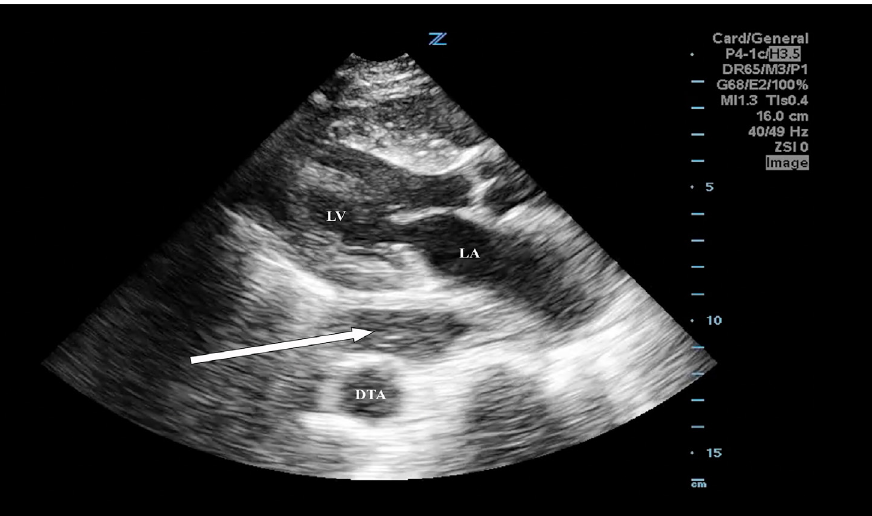
Image . Parasternal long-axis window with anechoic mass (arrow) with microbubbles posterior to the left atrium (LA) and left ventricle (LV) but anterior to the descending thoracic aorta (DTA). Despite mimicking life-threatening aortic pathology, this is a fluid-filled hiatal